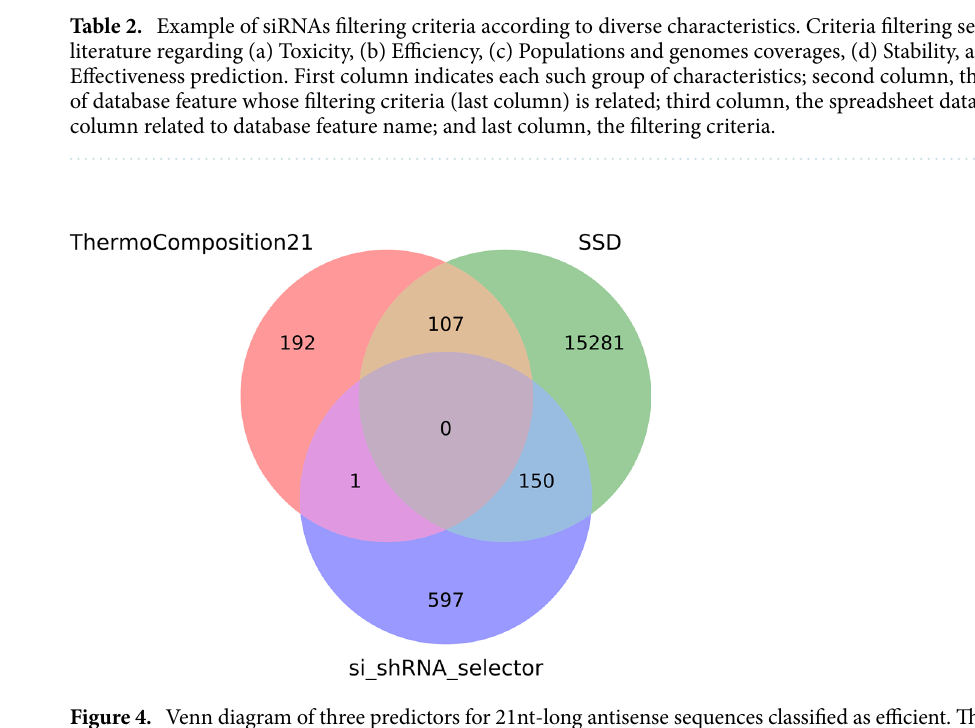
Figure 4. Venn diagram of three predictors for 21nt-long antisense sequences classified as efficient. The number of siRNAs that are simultaneously considered as effective by each pair of tools from ThermoComposition21, SSD and